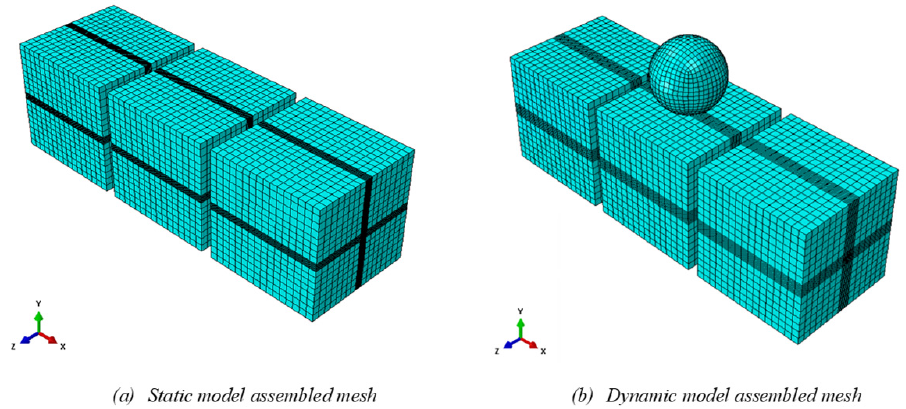
Figure 13. Overall model of mesh.